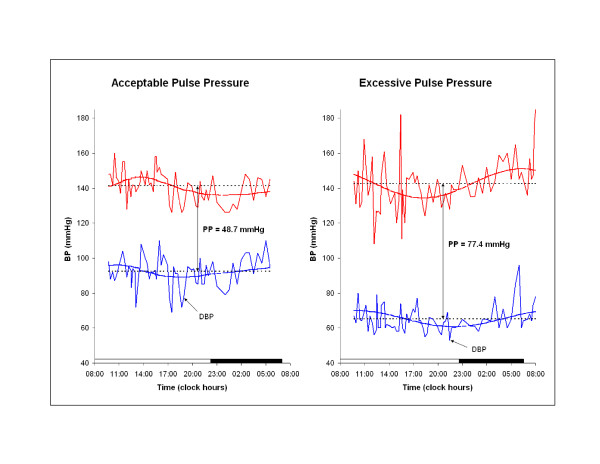
Acceptable and elevated pulse pressure.